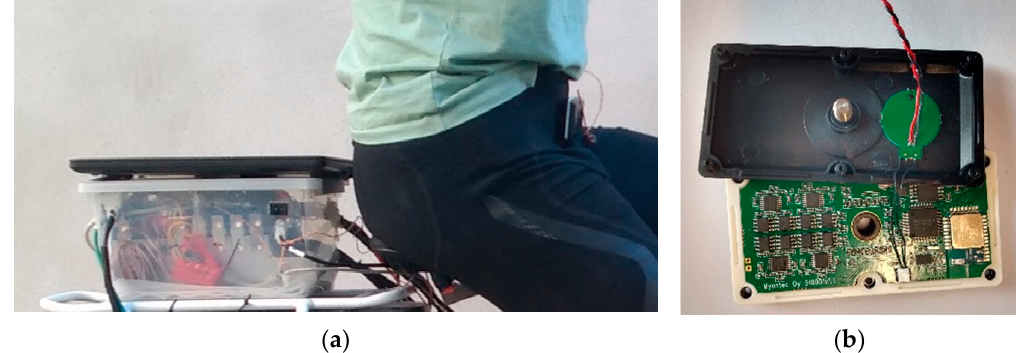
Figure 2. ( a ) Data acquisition system in box with notebook on top and wired connected to the Mcell of the EMG shorts; ( b ) adapted Mcell for synchronization with the compactDaq and Arduino.